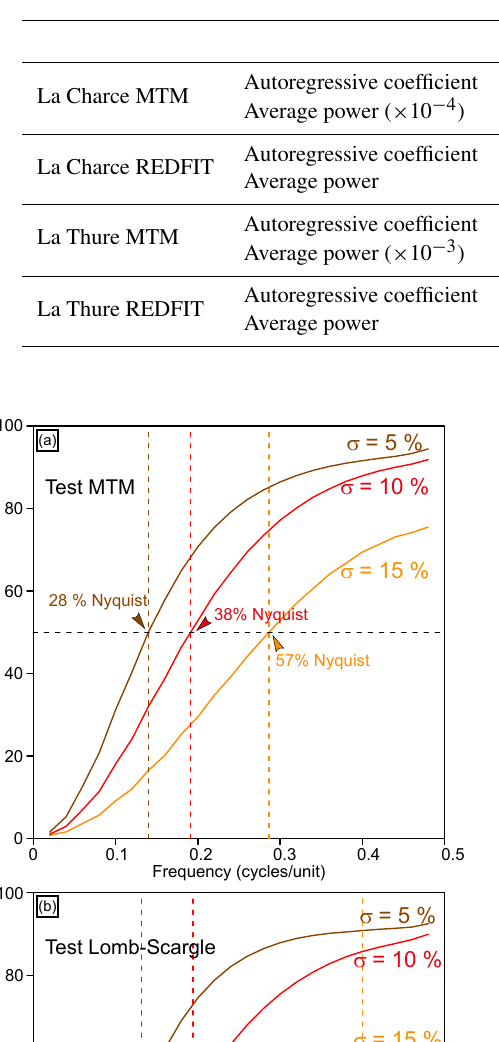
Table 1. Results of red-noise background estimates from the La Charce and the La Thure series with the 2 π MTM and the REDFIT analyses.